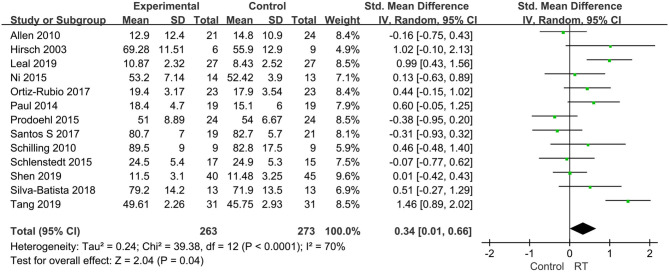
Forest plots of the effects of lower limb RT on balance performance in PD. CI, confidence interval.